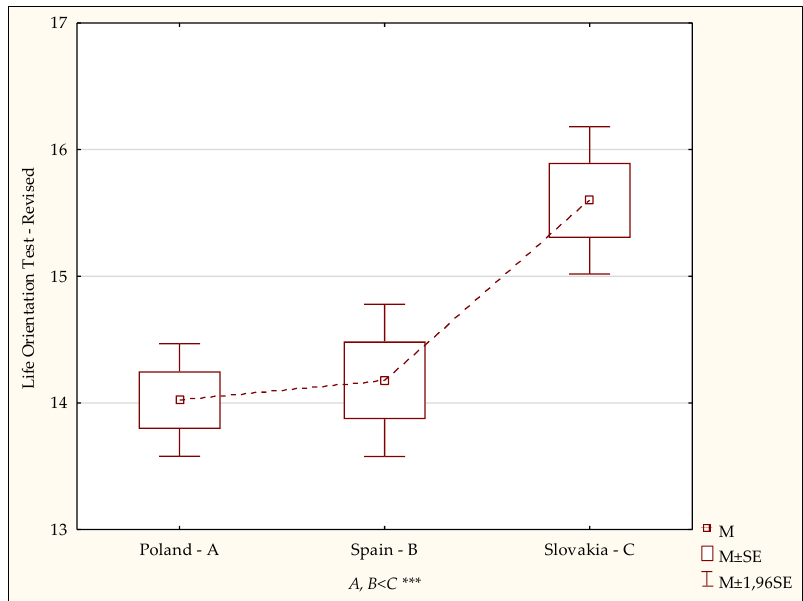
Figure 4. Intensity of dispositional optimism—diversity of scores. Statistically significant: *** p < 0.001.